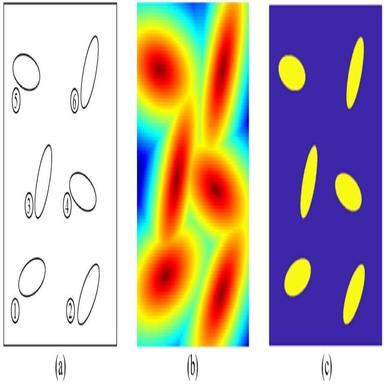
The RVE-FCNN layer of the RVE-net for material properties calibration.